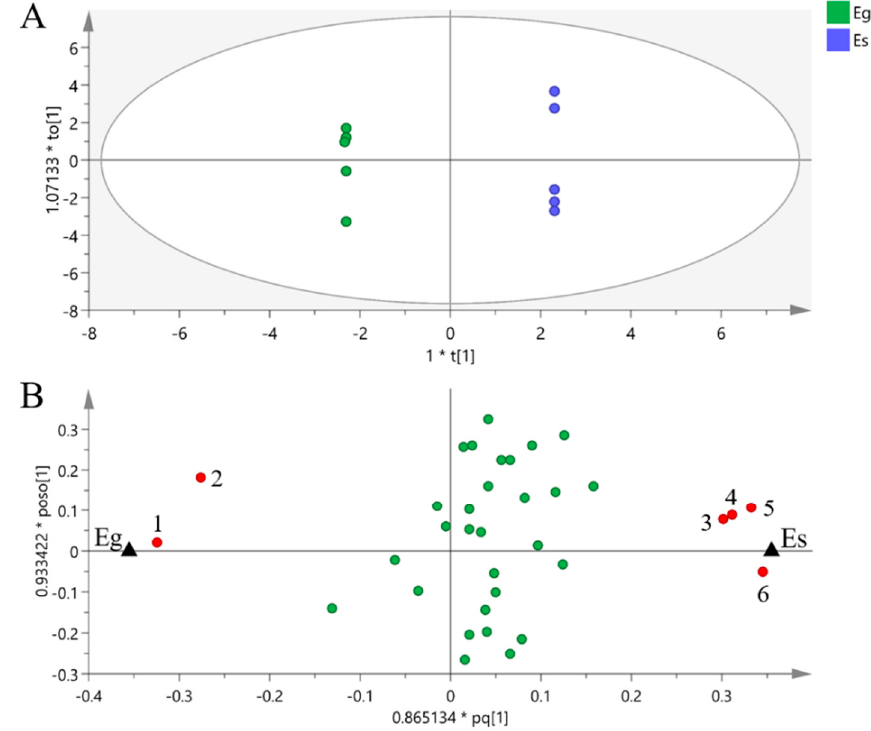
Figure 2. Orthogonal partial least squares discriminant analysis (OPLS-DA) of the metabolic pro- files of Epichloë gansuensis (Eg) and Epichloë sibirica (Es). OPLS-DA: 1 + 5 + 0 latent variables, with R 2 X = 0.755, R 2 Y = 1.000, Q 2 = 0.699. The ellipse in score plot ( A ) defines the 95% Hotelling’s T2 confidence region, and the symbols refer to samples. The symbols in loading plot ( B ) refer to compounds in metabolic profiles, the red symbols refer to differential metabolites screened between Eg and Es (VIP > 1, p < 0.05), (1) proline, (2) glutamic acid, (3) trans-9-octadecenoic acid, (4) tyrosine, (5) treha- lose, (6) α -linolenic acid, and the green symbols refer to metabolites with no significant difference.